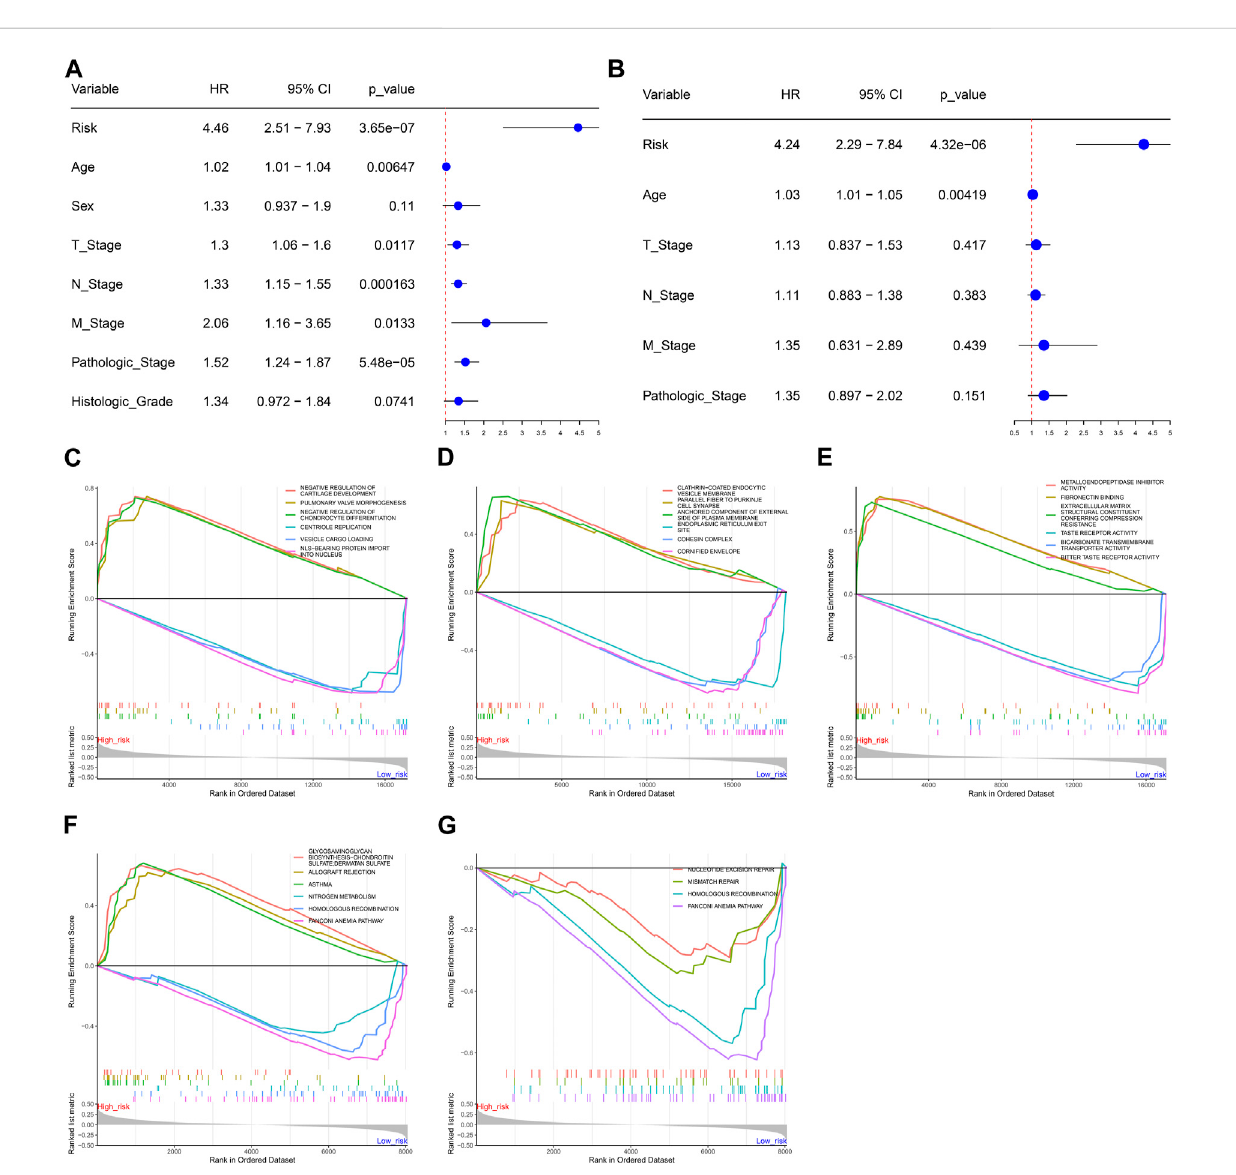
FIGURE 7 Independency of the DNA damage repair-relevant signature in prognosis prediction and underlying molecular mechanisms in the TCGA-STAD dataset. (A,B) Forest plots of the relationships of the DNA damage repair-relevant signature with OS via adopting uni- and multivariate cox regression methods. (C – G) GSEA of the enrichment levels of biological processes, cellular components, molecular functions, KEGG pathways, and DNA damage repair pathways in the low- and high-risk